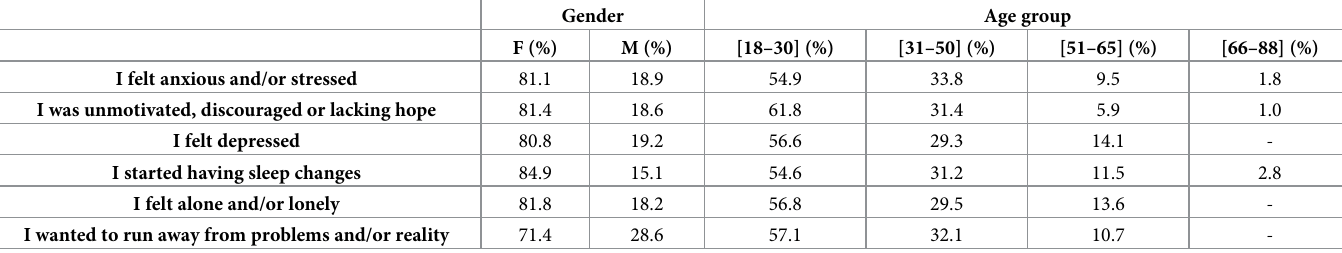
Table 5. Reasons that led to the consumption of pharmaceuticals according to gender and age group.